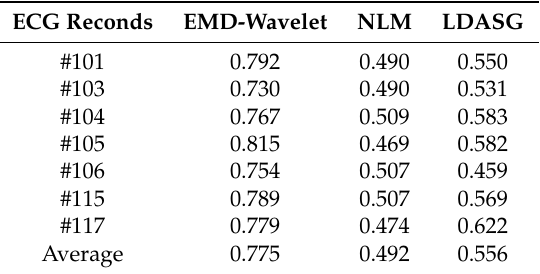
Table 2. Comparison of the computation time of different methods